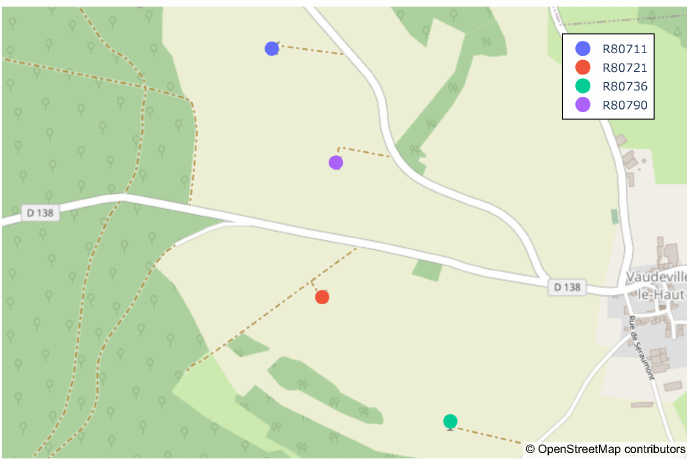
Figure 1. Layout of the “La Haute Borne” wind farm in France. The farm is composed of four identical MM92 wind turbines produced by Senvion identified as R80711, R80721, R80736, and